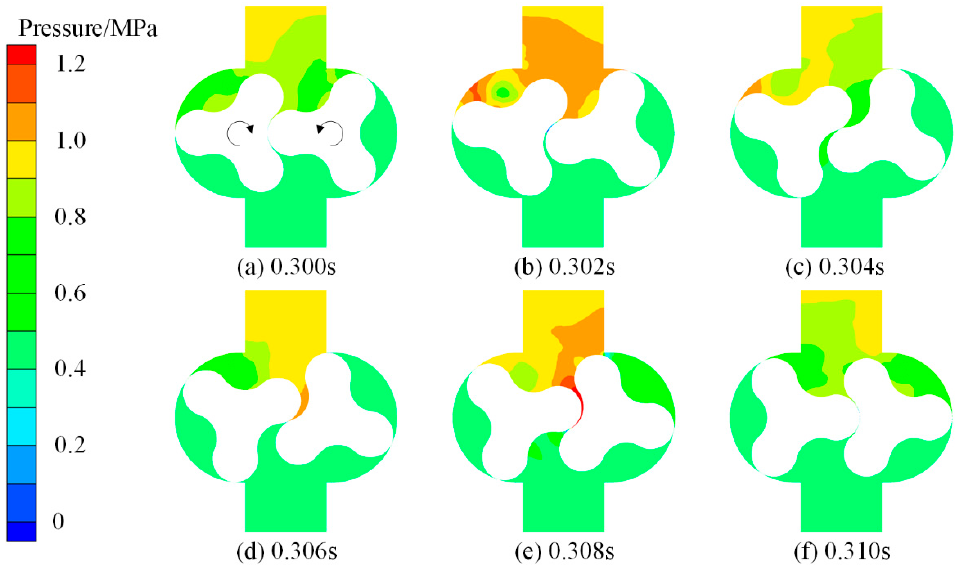
Figure 18. Static pressure contours of the Roots pump when the rotational speed is 1000 rpm. Flow time: ( a ) 0.300 s; ( b ) 0.302 s; ( c ) 0.304 s; ( d ) 0.306 s; ( e ) 0.308 s; ( f ) 0.310 s.